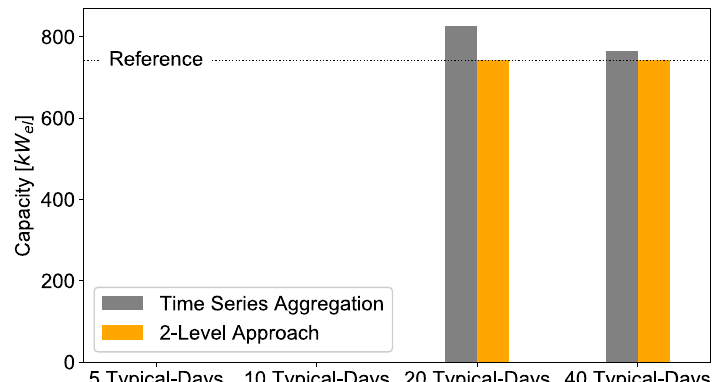
Figure 17. Deviation of installed electrolyzer capacities with the 2-Level Approach and time series aggregation compared to full time series.